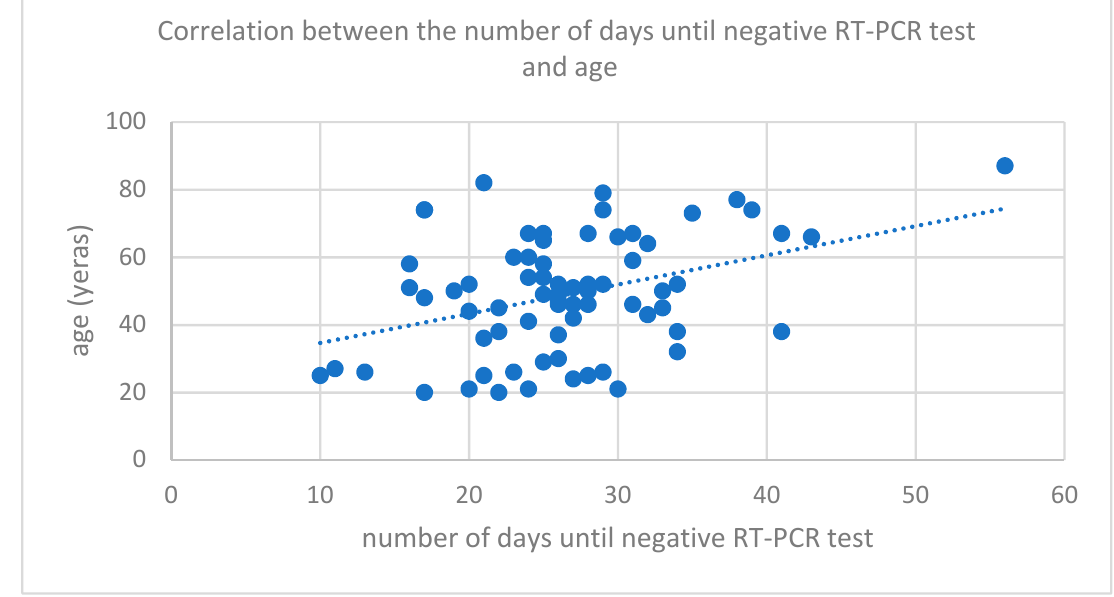
Figure 1. Correlation between number of days until negative RT-PCR test and age.